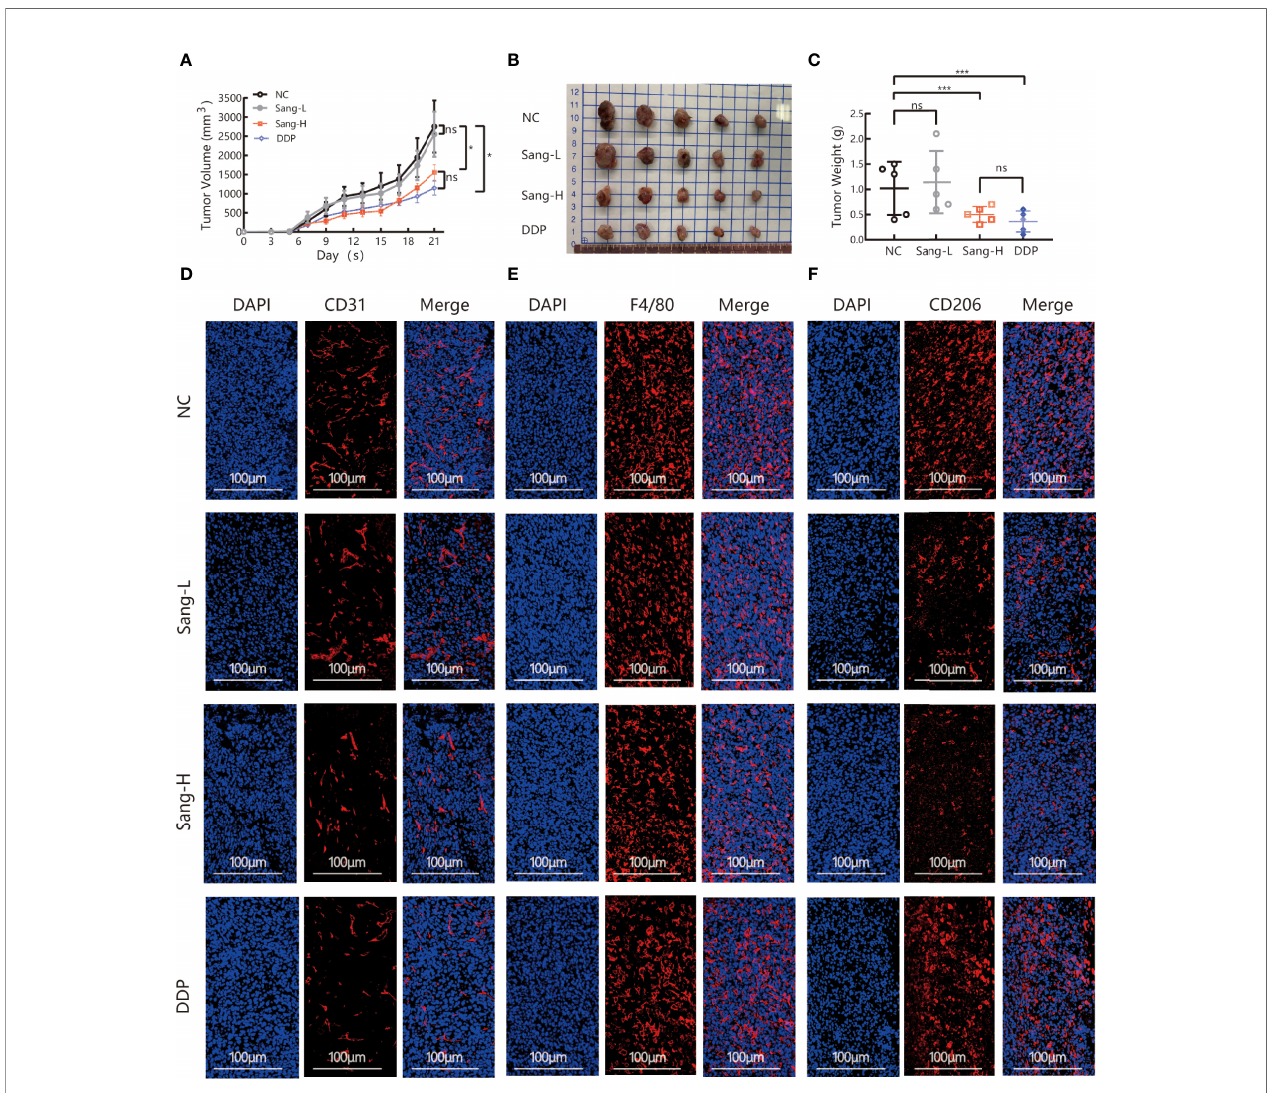
FIGURE 1 | Sang may inhibit tumor growth andangiogenesis inmice through a TAM-dependent mechanism.A total of 5 × 10 5 LLCs per mouse were subcutaneously injectedinto the right fl ankof C57BL/6 mice, and then mice were intraperitoneally injected with saline (0.1 ml/mouse),Sang(2.5 mg/kg, 5 mg/kg)orcisplatin (2mg/kg) from day 2. Tumor size was measuredevery 2 days, andfollowingtreatment for 3 weeks, the mice were sacri fi ced, andtumor tissues were isolated. Data are presented as the mean ± SEM of measurements from fi vemice per group.* p < 0.05; *** p < 0.001. ns, not statistically signi fi cant ( p > 0. 05 ). (A) Tumor volume curves; (B) Tumor tissues collected at the end point; and (C) Tumorweights. (D) The expression ofCD31, (E) F4/80, and (F) CD206 in the subcutaneoustumor tissue of lungcancer mice were revealed byimmuno fl uorescence staining. Nucleuswas stained with DAPI solution.Scalebars: 100, 100, and100 m